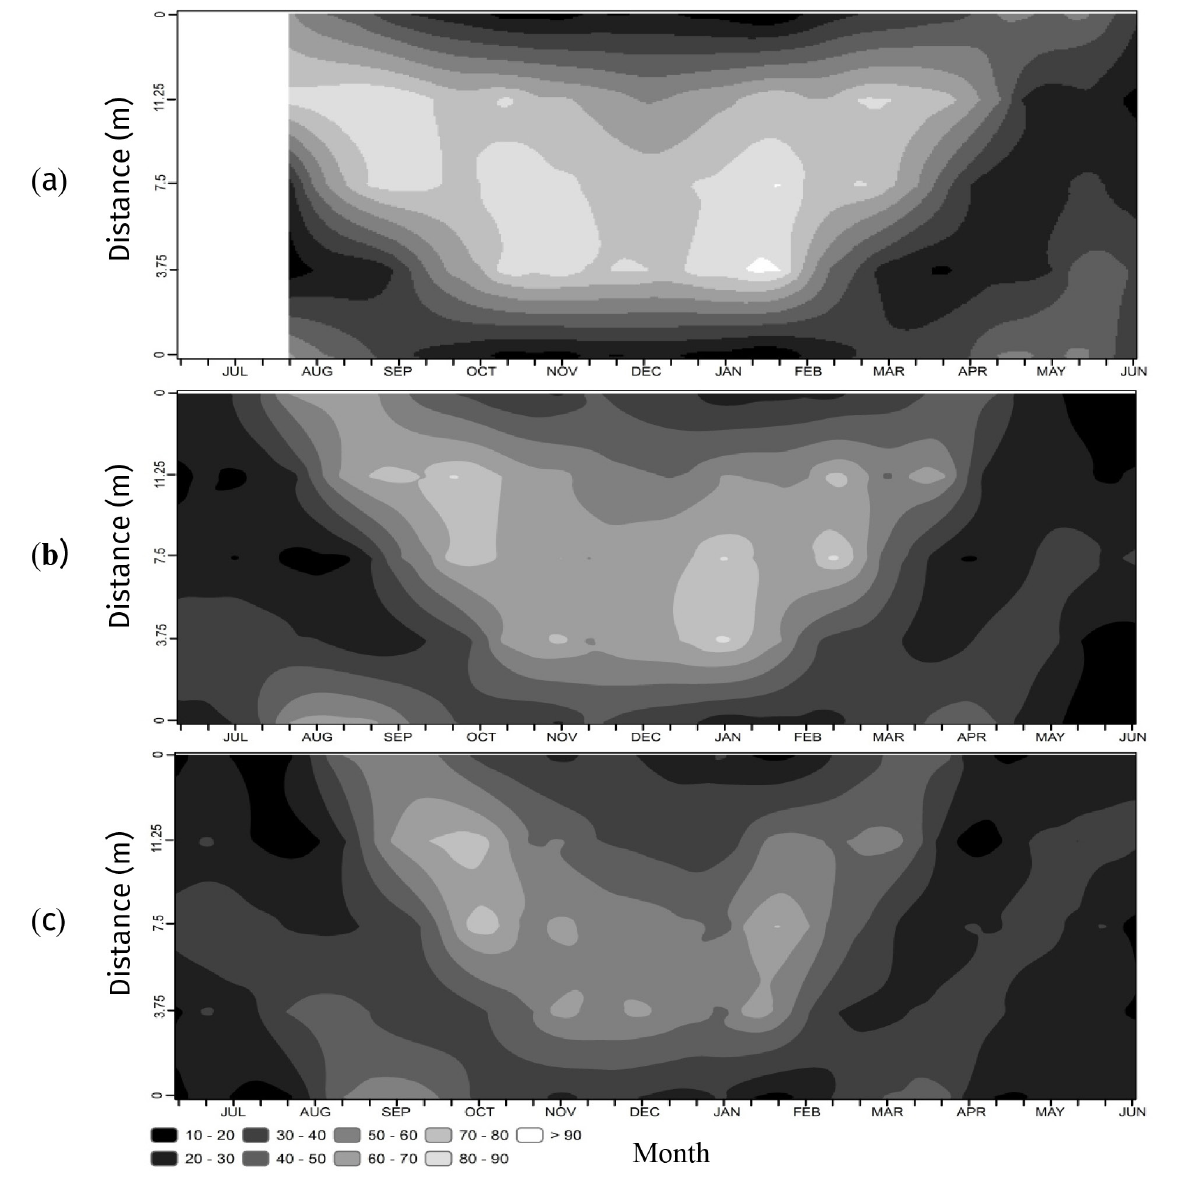
Figure 3. Spatial and temporal photosynthetically active radiation transmission (PARt) between rows of a silvopastoral system, every ten-day period during the three years of the study, from July to June. ( a ) year 1 (starting from August 2013), ( b ) year 2, and ( c ) year 3. Interpolation made by the Natural Neighbor